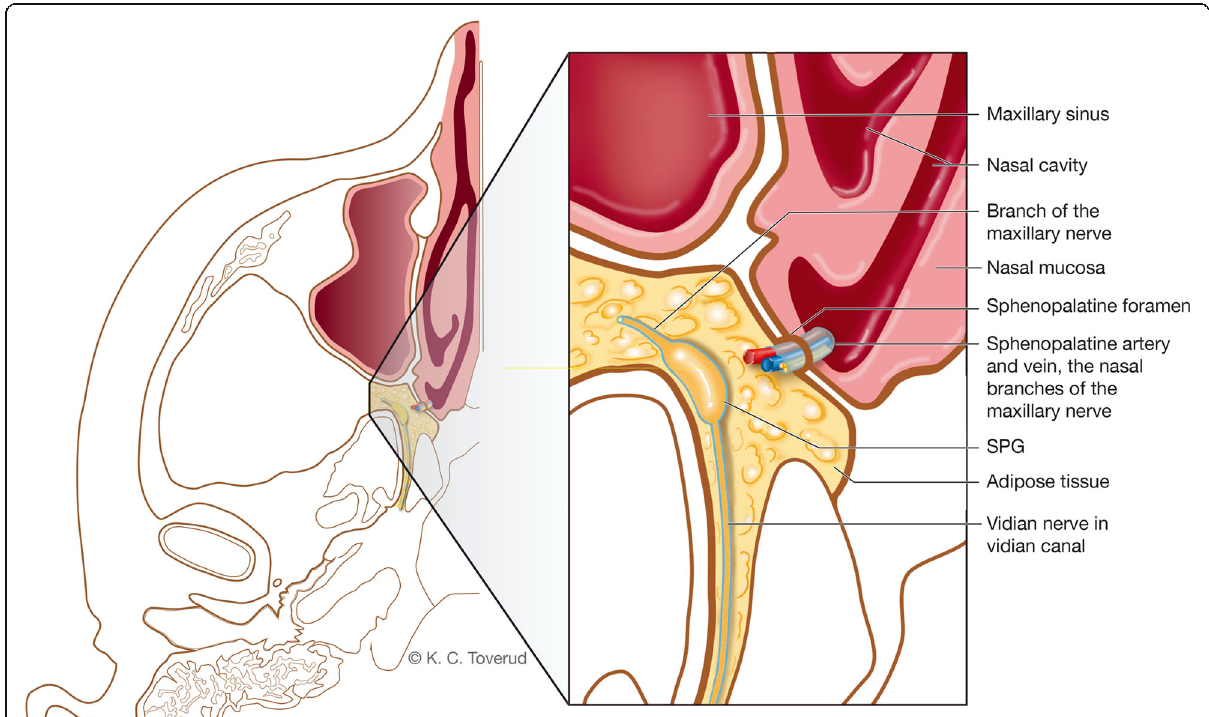
Fig. 2 Illustration of the relation between the nasal cavity and the sphenopalatine fossa (axial plane). In order to reach the SPG, a drug applied intranasally over the sphenopalatine foramen will have to diffuse through mucosa, the sphenopalatine foramen, which is packed with neuro-vascular structures and connective tissue, and the fat tissue filling the sphenopalatine fossa. SPF: sphenopalatine foramen; SPG: sphenopalatine ganglion